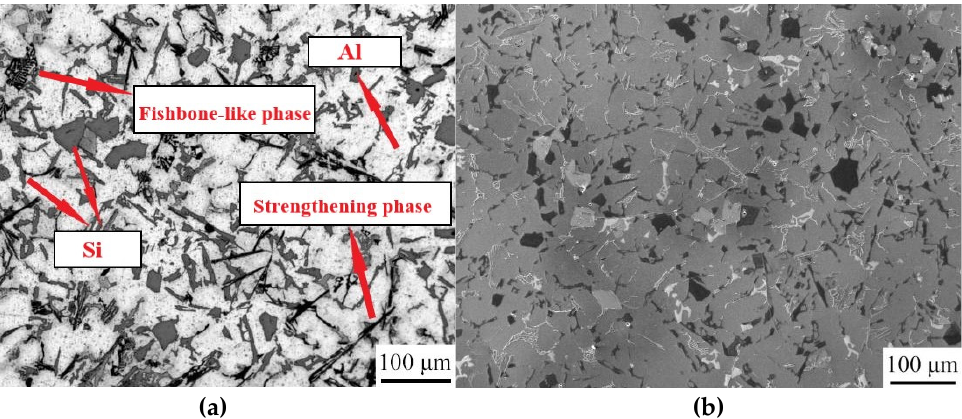
Figure 3. Microstructure of Al-Si-Cu-Ni-Mg alloy under ( a ) metallography and ( b ) scanning electron microscopy.